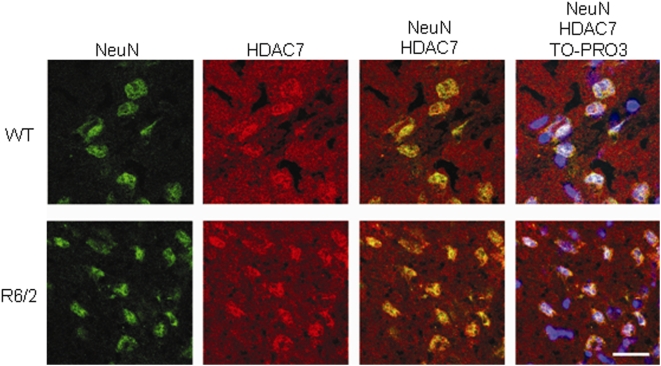
HDAC7 is present in the nucleus and cytoplasm of neuronal cells in the mouse striatum.Representative confocal microscopy images of coronal sections of brains from wild-type (WT) and R6/2 transgenic mice at 14 weeks of age immuoprobed with antibodies to NeuN to identify neurons and with anti-HDAC7. Nuclei were visualized using TO-PRO-3 (blue). Scale bar 20 µm.